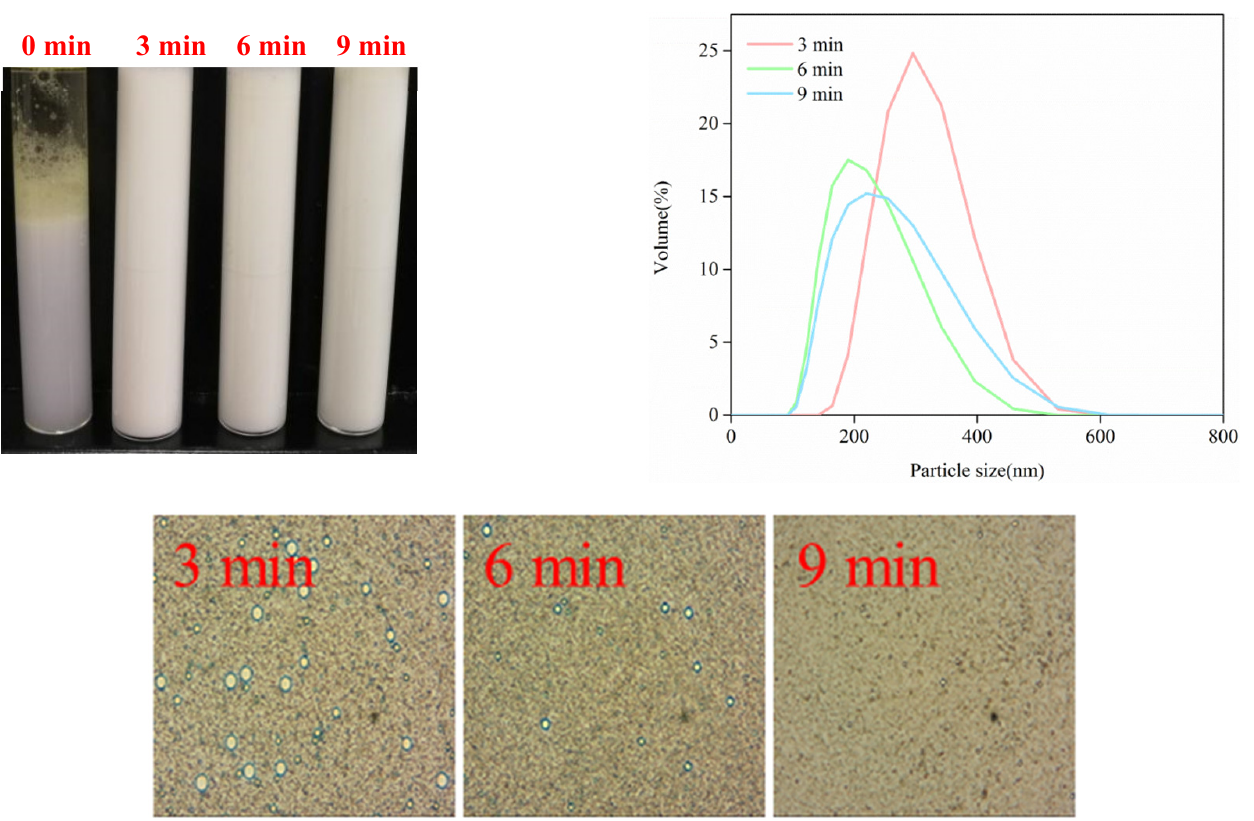
can be adsorbed to the interface of oil droplets, forming the stability of emulsions due to the above physicochemical and structural changes of SC. Under various environmental stresses, the stability of ultrasound-treated emulsions inhibited flocculation and coales- Figure 8. Effect of freeze–thaw treatment on the visible appearance, particle size distribution and Figure 8. Effect of freeze–thaw treatment on the visible appearance, particle size distribution and cence. High-intensity ultrasounds enhanced SC-coated O/W emulsion stability. microstructure of SC-coated O/W emulsions by a high-intensity ultrasound treatment. microstructure of SC-coated O/W emulsions by a high-intensity ultrasound treatment.